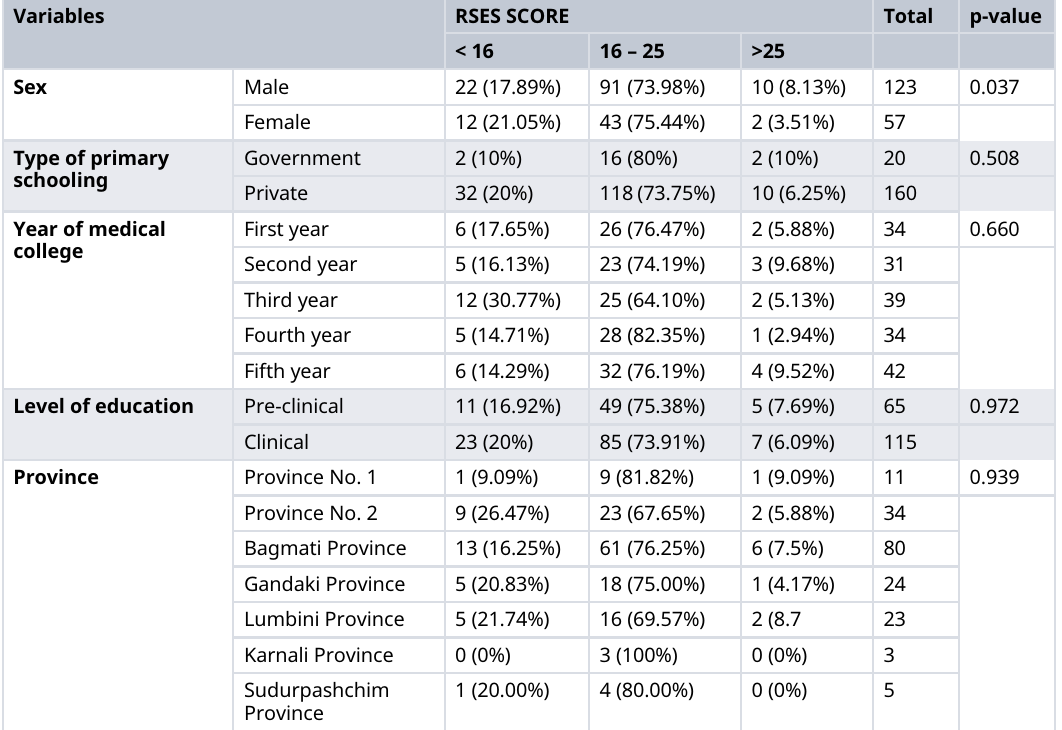
Table 1. Socio-demographic characteristics and RSES of the students along with p-